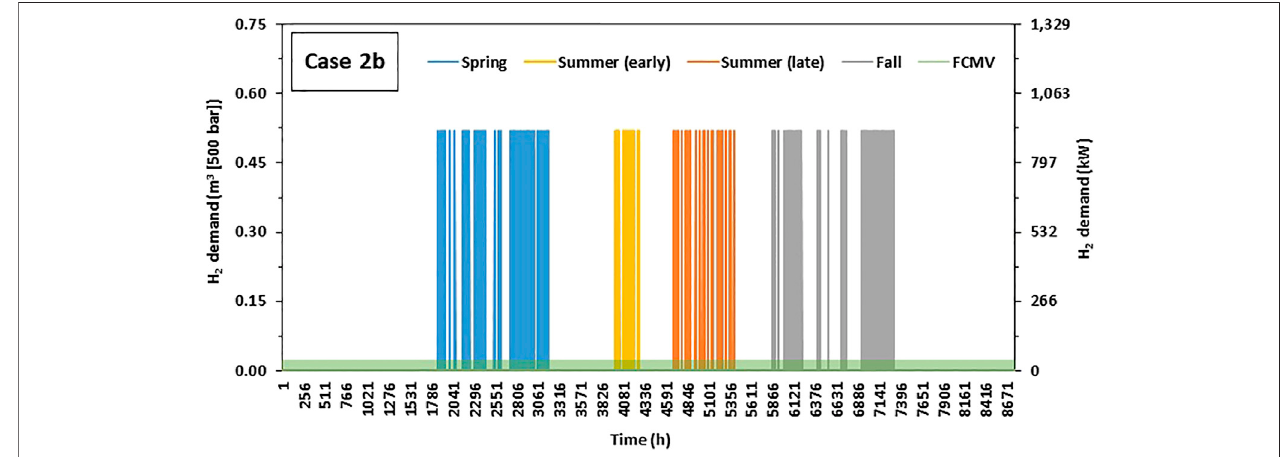
FIGURE 5 | H 2 demand pro fi le of the cereal farm system for the case 2b. Note: Detailed description of the agricultural activities carried out in each season is provided by Lagnelöv et al. (2020); FCMV - fuel cell minivan.